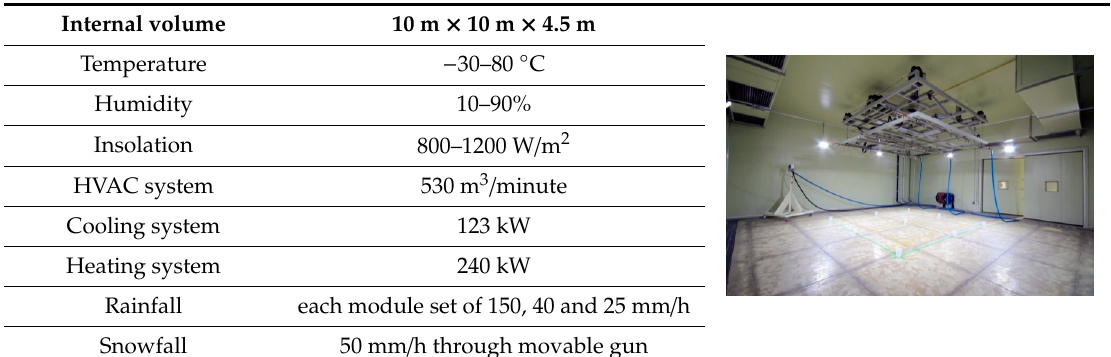
Table 5. Specifications of real-scale climatic environment chamber.